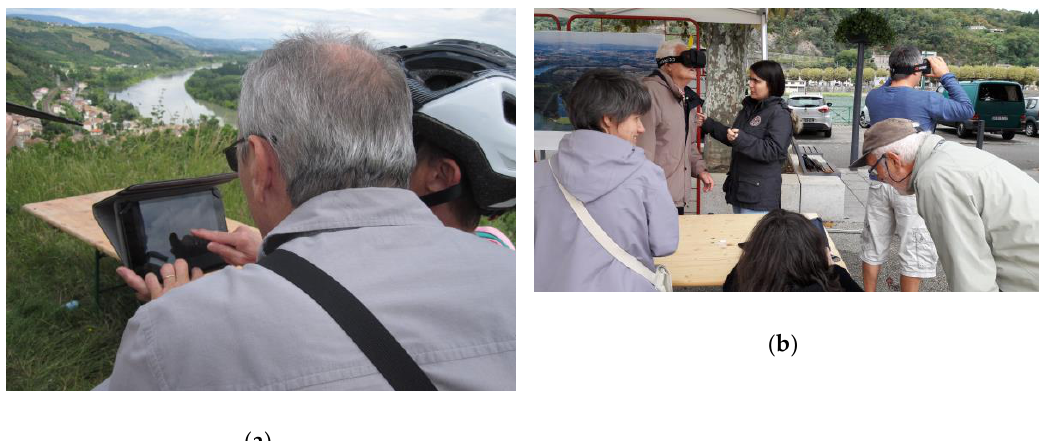
Figure 6. Pictures taken during the events: ( a ) shows inhabitants consulting the 3D geovisualization with a tablet from a high vantage point (same viewpoint as the one selected for the images of the simulated flood they are visualizing); ( b ) shows inhabitants using the VR headset (background), while another is being shown the tablet by a mediator